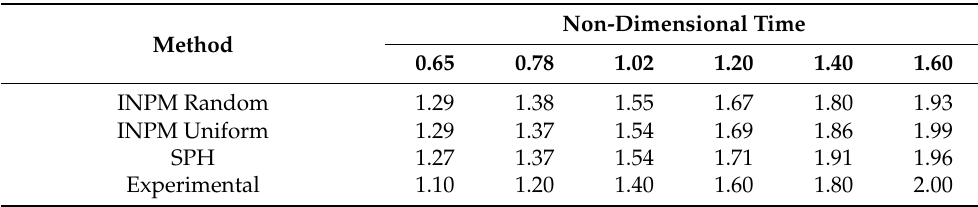
Table 1. Comparison of the non-dimensional leading-edge position versus the non-dimensional time from INPM, SPH, and experimental data.